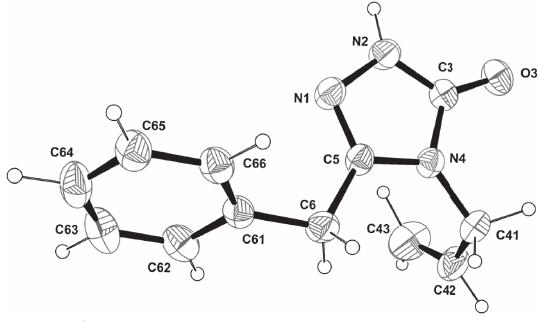
Table 1: Data collection and handling.